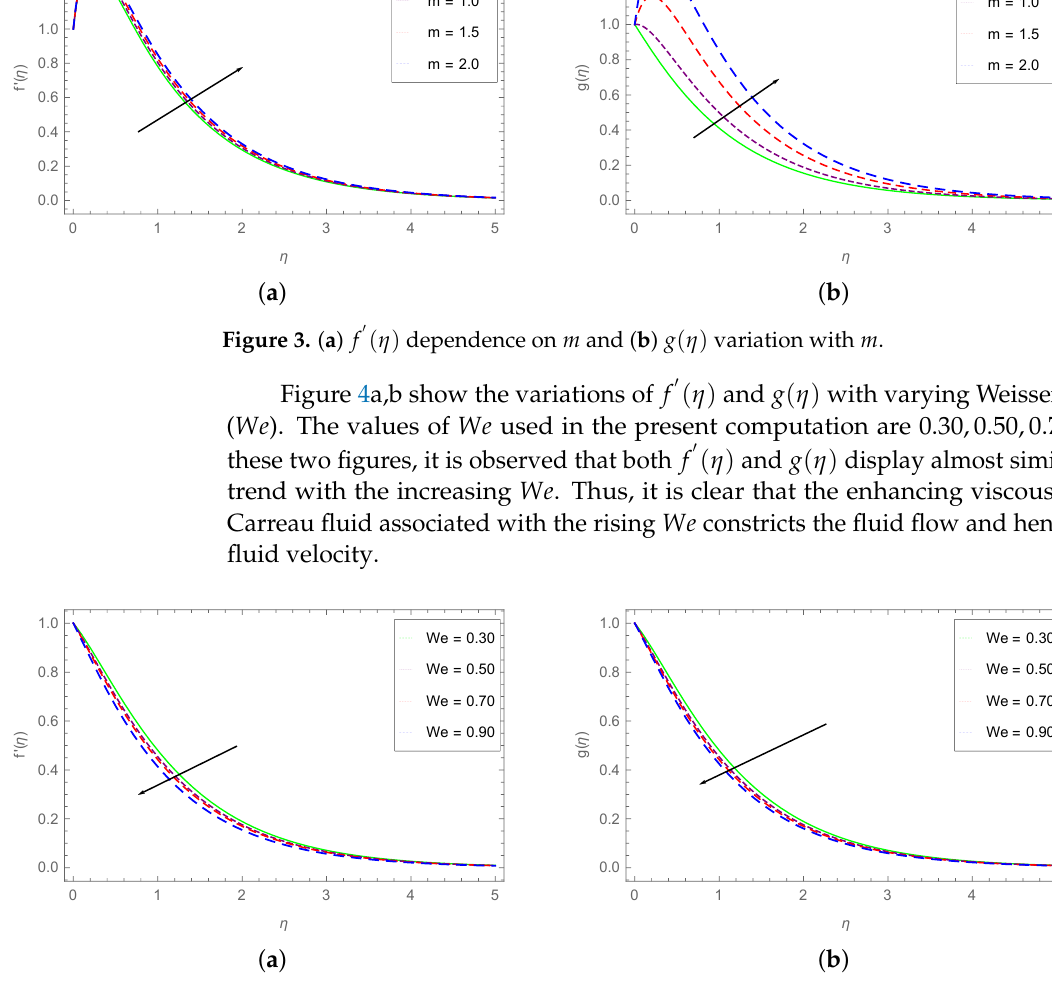
Figure 4. ( a ) f (cid:48) ( η ) dependence on We and ( b ) g ( η ) dependence on We